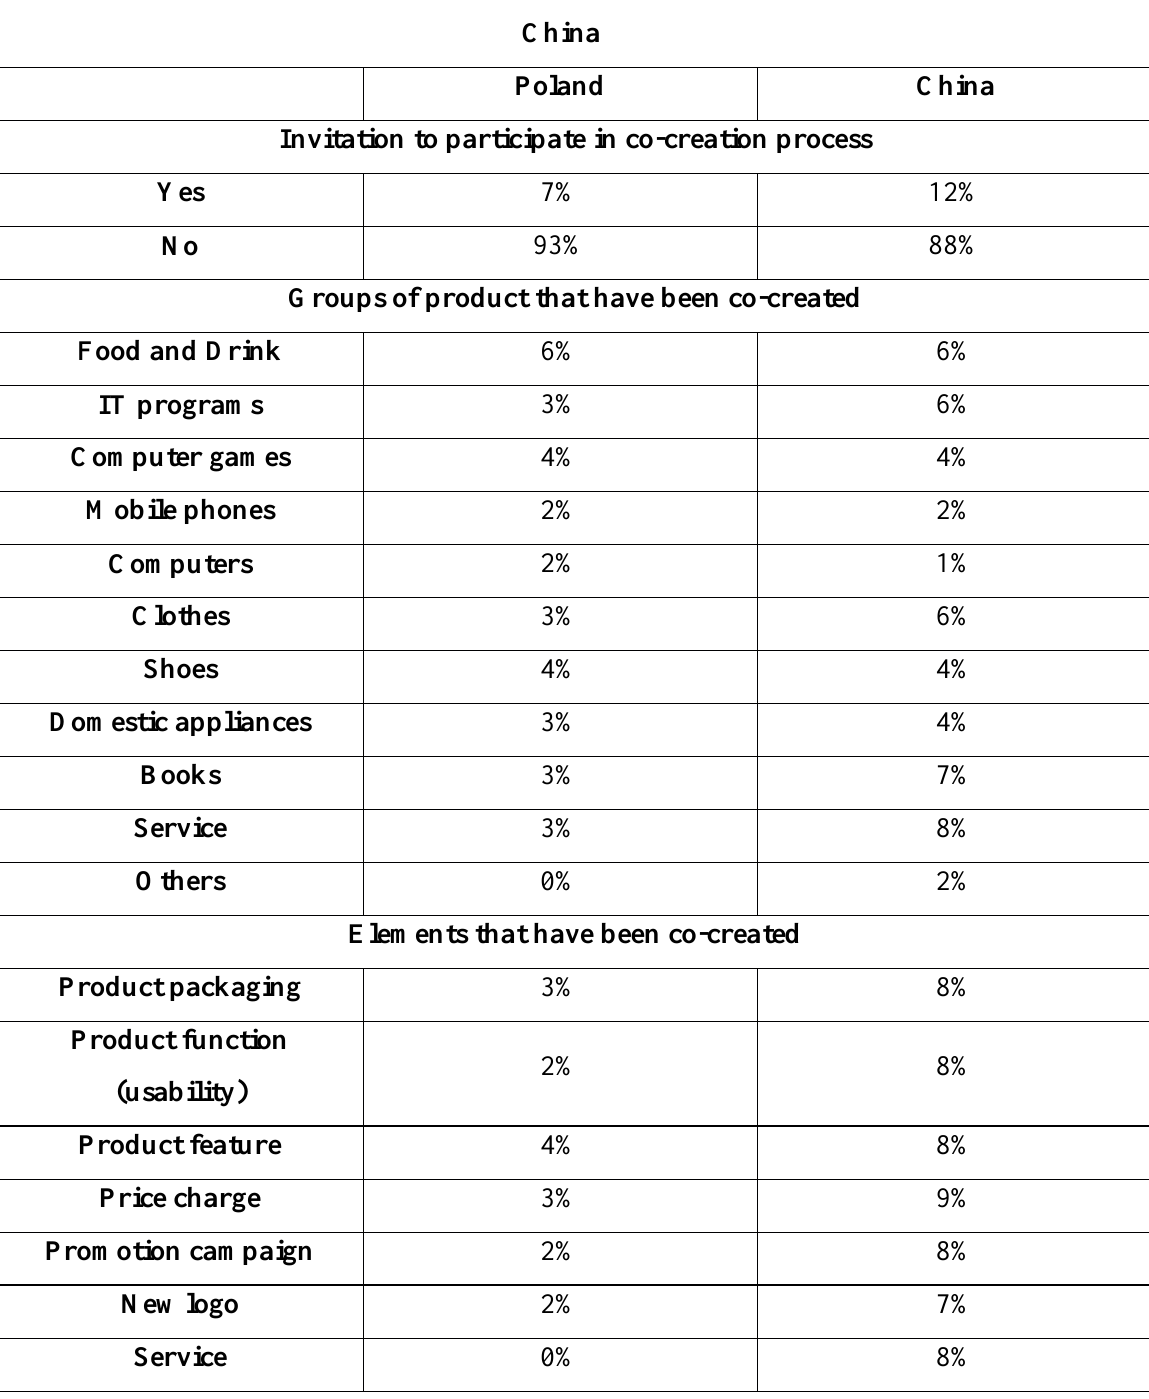
Table 2: The involvement of young people in the co-creation process in Poland and in China Poland